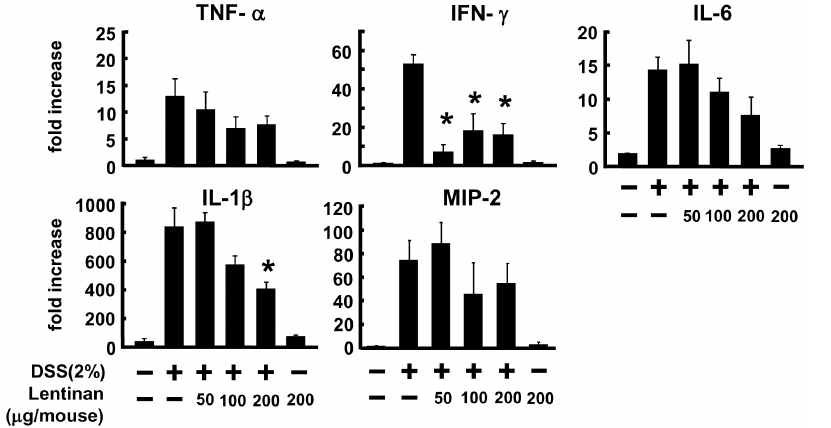
Figure 2. Lentinan improves inflammatory cytokines mRNA expression in colon tissues of DSS-induced colitis. Total RNA was extracted from the colon tissues of untreated and DSS-treated mice on day 10. TNF- a , IFN- c , IL-6, IL-1 b , and MIP-2 mRNA expression were measured by quantitative RT-PCR. Values represent the means 6 SE ( n =6). Significance compared with a DSS-treated group, * P , 0.05.